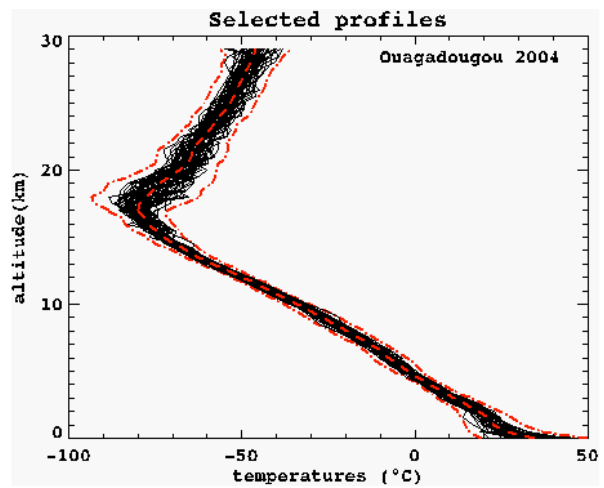
Fig. 2. Selected vertical profiles of temperature for heights less equal than 27km at Ouagadougou in